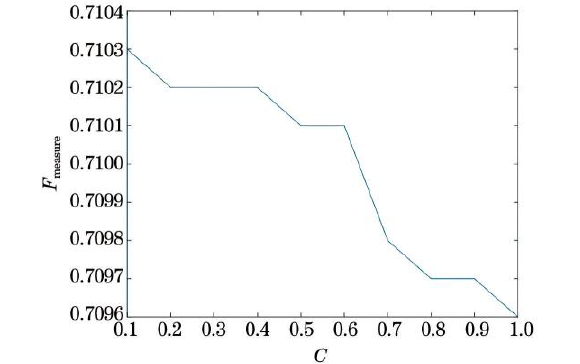
Figure 7. F-measure values under the different C values on Airport dataset.